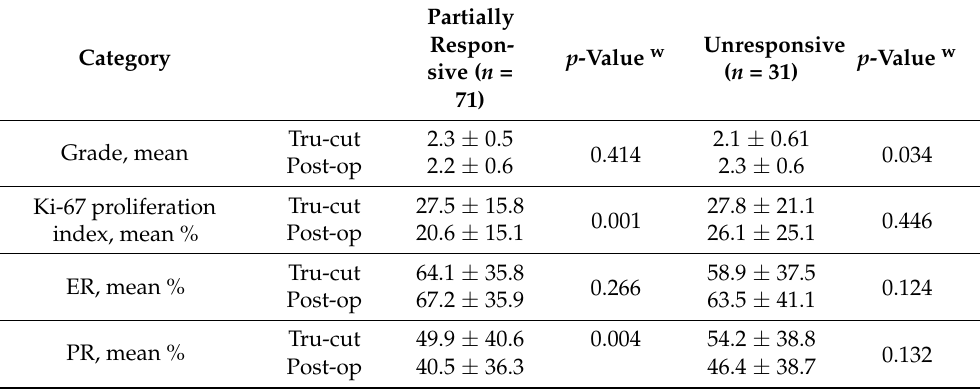
Table 8. Tumor grade, Ki-67 proliferation index, and ER and PR expression levels of partially responsive and unresponsive patients. Category